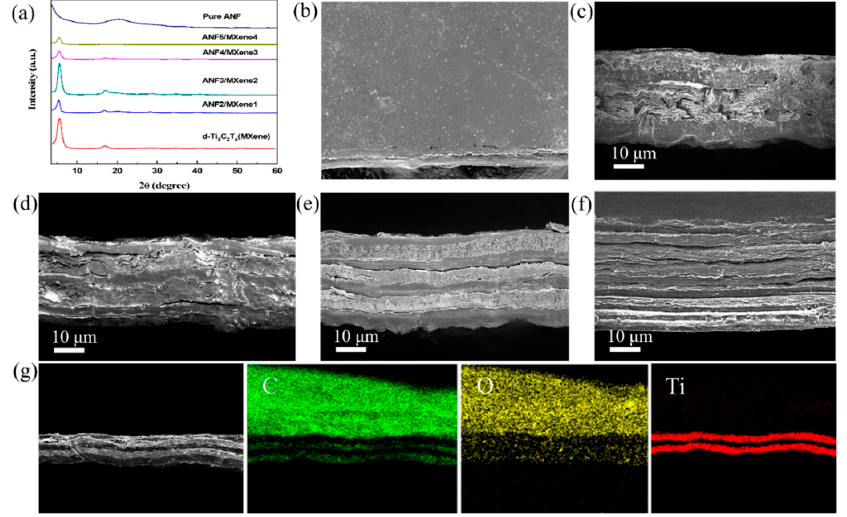
Figure 2. ( a ) XRD patterns of pure ANF, MXene and ANF/MXene multilayer-structure films; ( b ) SEM image of MXene1 film surface; ( c – f ) SEM images of cross-sections of films with different layers; ( g ) Elemental analysis of the cross-section of ANF3/MXene2 film. ( g ) Elemental analysis of the cross-section of ANF3/MXene2